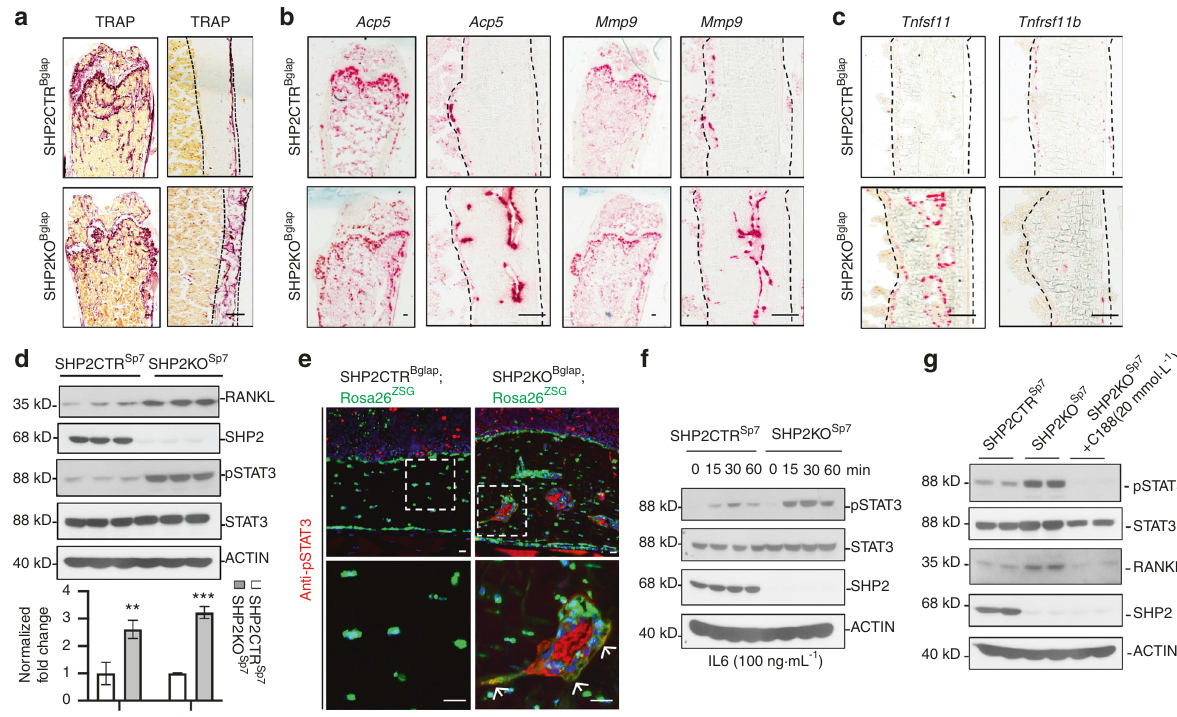
Fig. 4 Mice lacking SHP2 in Bglap + osteoblastic cells display elevated local osteoclastogenesis and bone resorption. a Femoral frozen sections from the indicated 13-week-old mice show the activity of tartrate-resistant acid phosphatase (TRAP). Note the markedly increased TRAP activity in the cortical bone of SHP2 mutants compared to control mice. The quantitative data are provided in Fig. S2d. Scale bar: 100 μ m. b Femoral frozen sections show the transcript abundance of the indicated osteoclastic genes in the metaphysis and diaphyseal cortical bone using RNAScope ® technology ( n = 3 – 4). Scale bar: 100 μ m. c Femoral frozen sections show the transcript abundance of RANKL (Tnfsf11) and OPG (Tnfrsf11b) in the diaphyseal cortical bone using RNAScope ® assays ( n = 3). Scale bar: 100 μ m. d Western blots show the expression of RANKL and SHP2 and the phosphorylation of STAT3 Y705 in osteoblast cell lines derived from the indicated mice. e Femoral frozen sections immunostained with antibodies against pSTAT3 Y705 demonstrate STAT3 activation in the OBs (arrows) ( n = 4). Scale bar: 100 μ m. f Western blots show the abundance and activation of STAT3 in SHP2-suf fi cient and SHP2-de fi cient OBs upon IL6 stimulation. g Western blots show the abundance of STAT3, SHP2, and RANKL in SHP2-suf fi cient and SHP2-de fi cient OBs in the presence or absence of the STAT3 inhibitor C188. In all western blotting studies, ACTIN served as an internal loading control. The low-power full images of Fig. 4a – c shown in Figs S2c and deleted in Bglap-expressing cells, as evidenced by the decrease in the number of Dmp1- and Sost -positive cells, decreases in both the number and length of osteocyte dendrites in developing and adult SHP2KO Bglap mice (Figs 3 and S5), and compromised osteogenic gene expression (Fig. 5). Importantly, the above changes were also associated with a signi fi cant increase in tubular bone length (Fig. S2a) and local osteoclastogenesis (Fig. 4), and the restoration of OSTERIX expression in SHP2-de fi cient OBs and pharmacological inhibition of STAT3 activation restored osteogenic gene expression and normal RANKL production, respectively (Figs 4 and 5). Together, these data indicate that SHP2 is essential to support osteogenesis and bone mineral homeostasis by regulating the differentiation, maturation, and function of OBs and osteocytes and by repressing RANKL production and local osteoclastogenesis. The resemblance of the skeletal phenotypes in SHP2KO Bglap , RUNX2, and OSTERIX knockout mice suggests that SHP2 may signal through these molecules and their modulated signaling path- ways. 2,3,64 RUNX2 and OSTERIX are essential for osteoblastogenesis and skeletal development. Although global RUNX2 deletion in mice causes perinatal lethality, 65,66 inducible RUNX2 deletion in adult mice leads to decreased Osx expression, reduced BV, and excessive BM adipocyte accumulation. 67 These features are recapitulated in SHP2KO Bglap mice. Therefore, we investigated the interaction of SHP2 with RUNX2 and its effect on RUNX2 tyrosyl phosphorylation. Indeed, SHP2 was found to physically interact with RUNX2 in OBs, but its de fi ciency had no apparent in fl uence on RUNX2 global tyrosyl